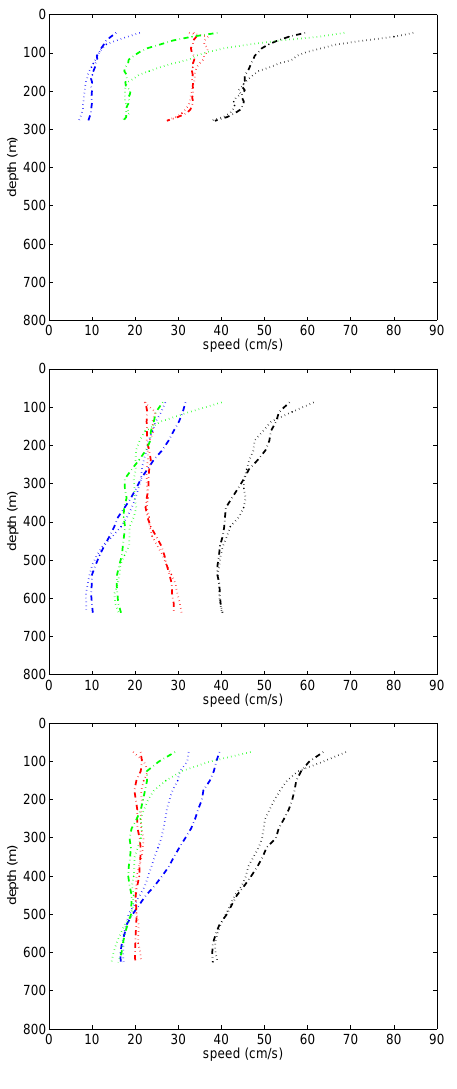
Fig. 11. Vertical profiles of 3 months averaged daily maximum speed for total currents (black), mean residual flow (blue), surge component (green) and tide (red) at locations SA, SB and SC from top to bottom. Continuous (–) line stands for average over June- September, dashed (- -) line stands for average over September– December, dotted (...) line stands for average over December– March and dash-dotted (-.-.) line stands for average over March– June.